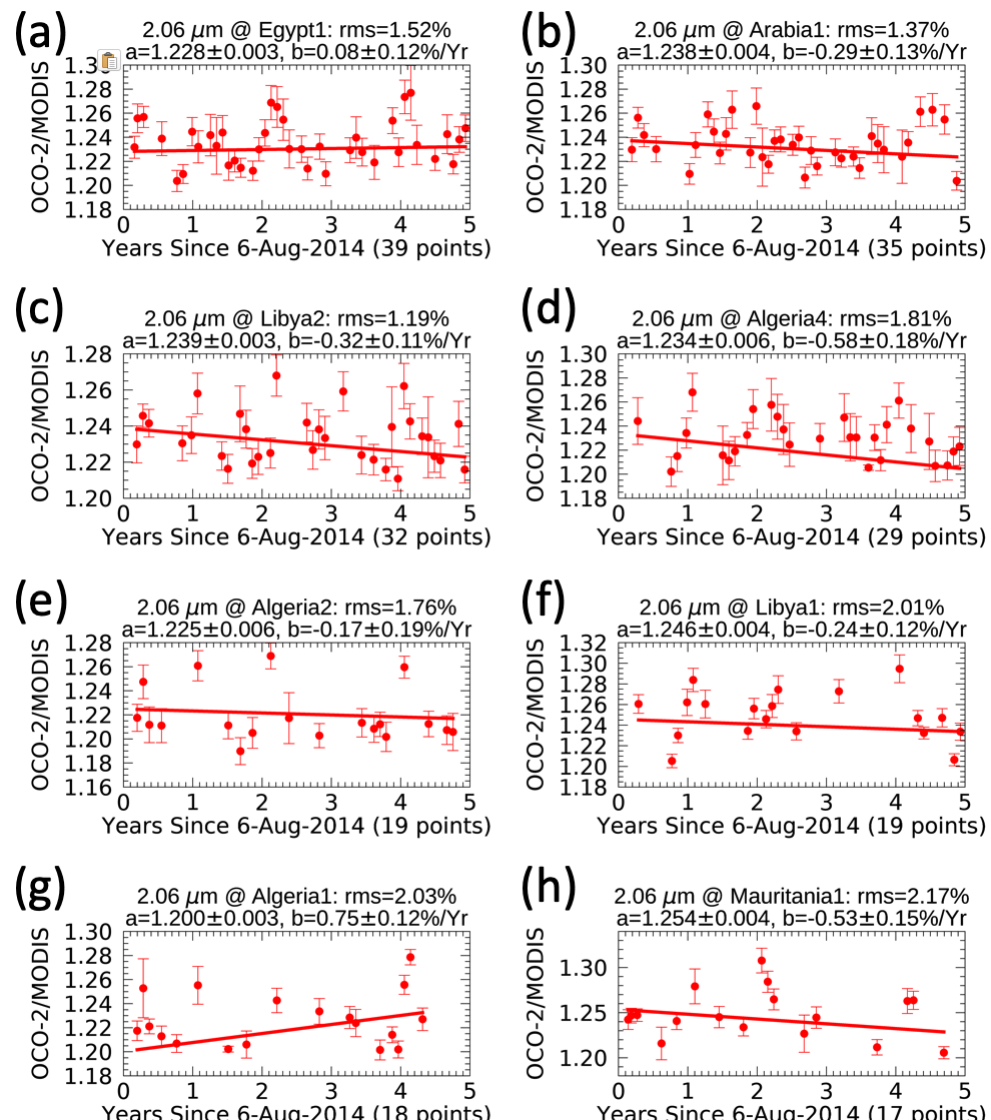
Figure A2. Five-year time series ofthe OCO-2/MODIS radiance ratio for OCO-2 Band 3 over eight desert sites: Panel ( a ) is over Egypt1; Panel ( b ) over Arabia1; Panel ( c ) over Libya2; Panel ( d ) over Algeria4; Panel ( e ) over Algeria2; Panel ( f ) over Libya1; Panel ( g ) over Algeria1; Panel ( h ) over